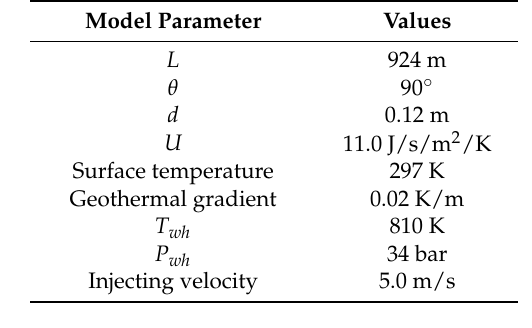
Table 1. Steam–CO 2 injection data.